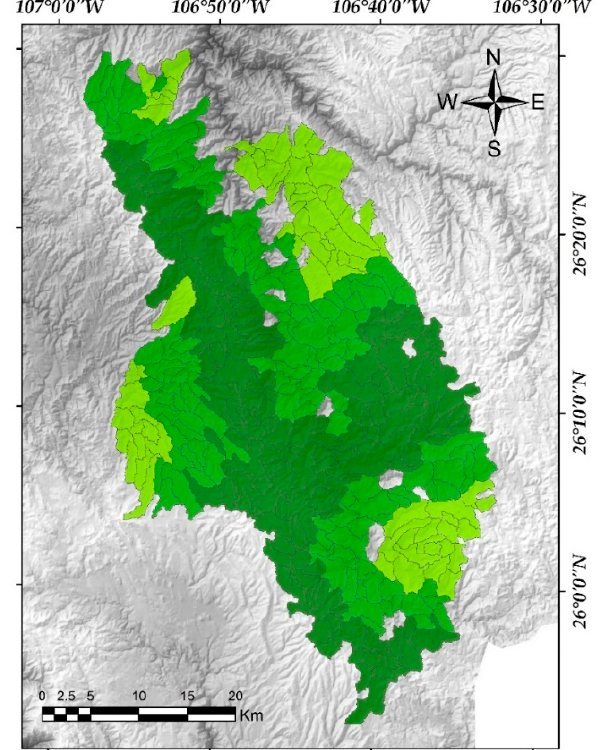
Figure 8. Spatial distribution of the 3 groups modified by the method of cross-validation of the Discriminant Analysis. Group 1( ● ), Group 2( ● ), Group 3( ● ). Name of colors: Bilbao ( ● ), Limeade ( ● ), Inch Worm ( ● ).